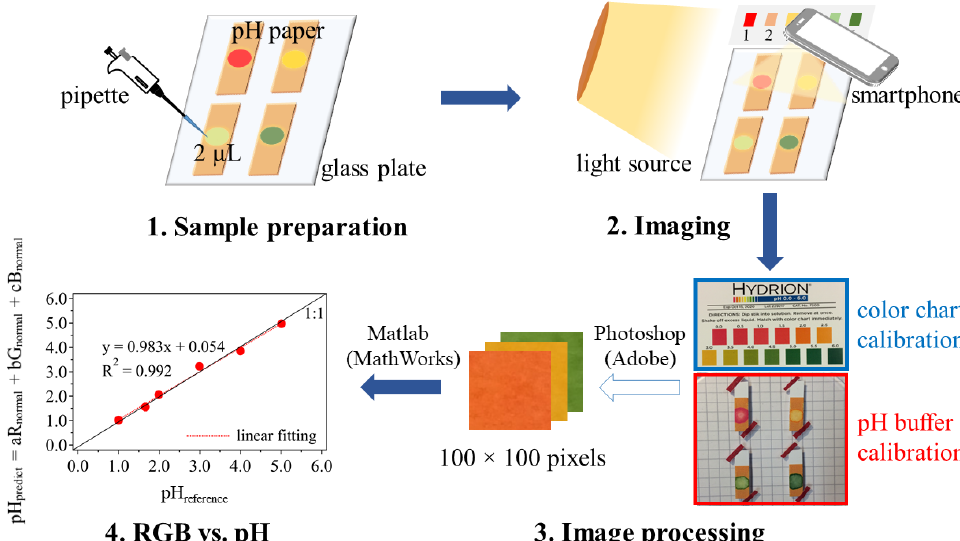
Figure 1. Schematic of using the RGB-based colorimetric method for pH estimation. For the color-chart-calibration method, both the color chart and the standard buffer samples are imaged into one digital photo for subsequent processing. For the standard-buffer-calibration method, only the standard buffer samples are used for imaging. Note that when using the standard-buffer-calibration results to predict the pH of aerosol samples, the photographing conditions for the samples are the same as those of the buffer